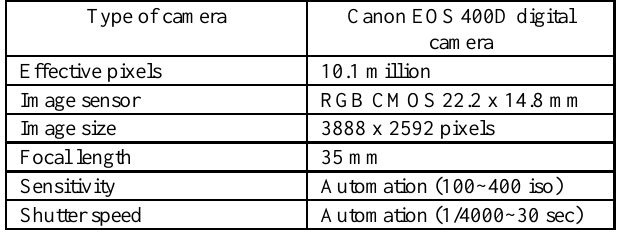
Table 1. Characteristics of the camera acquisition systems